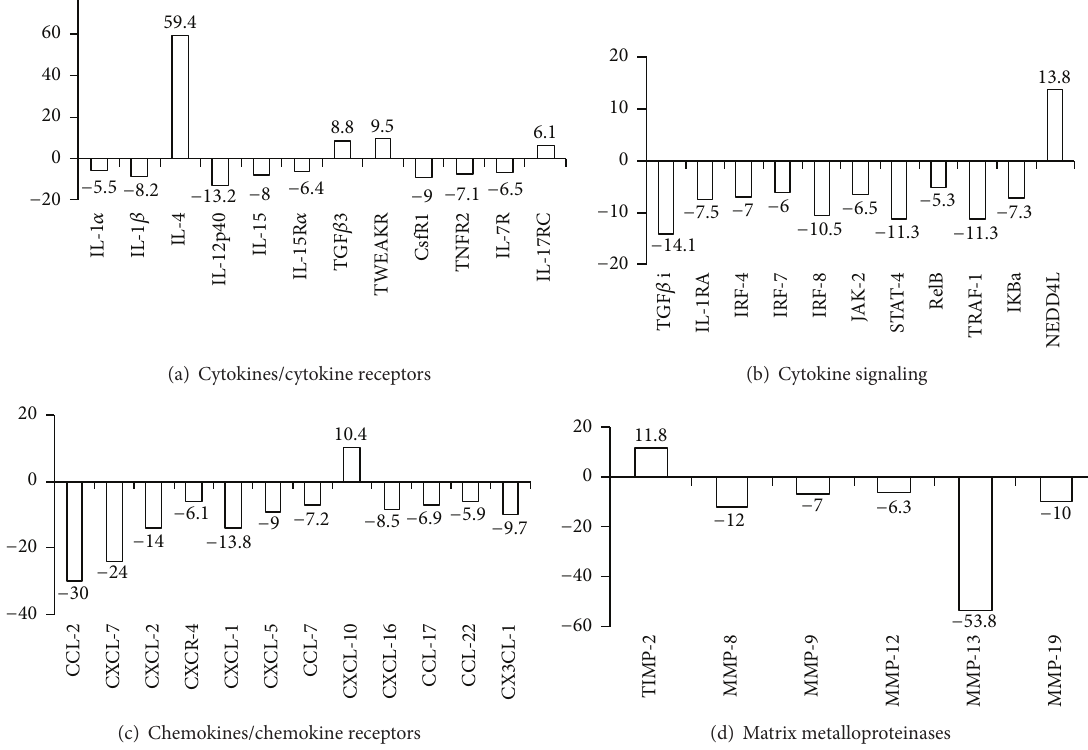
Figure2:Expressionprofileofcytokinesandcytokinereceptors.(a)Moleculesinvolvedincytokinesignaling,(b)chemokinesandchemokine receptors, and (c) matrix metalloproteinases (d). Data from microarrays are presented and fold differences in expression between DC- tumor cell hybrids and DCs are shown. Positive values indicate upregulation in DC-tumor cell hybrids, while negative values indicate downregulation. When expression levels from different probe sets were available for the same gene product (IL-12p40, CsfR1, TGF 𝛽 i, IL- 1RA, and TIMP-2), the average of their values was presented.